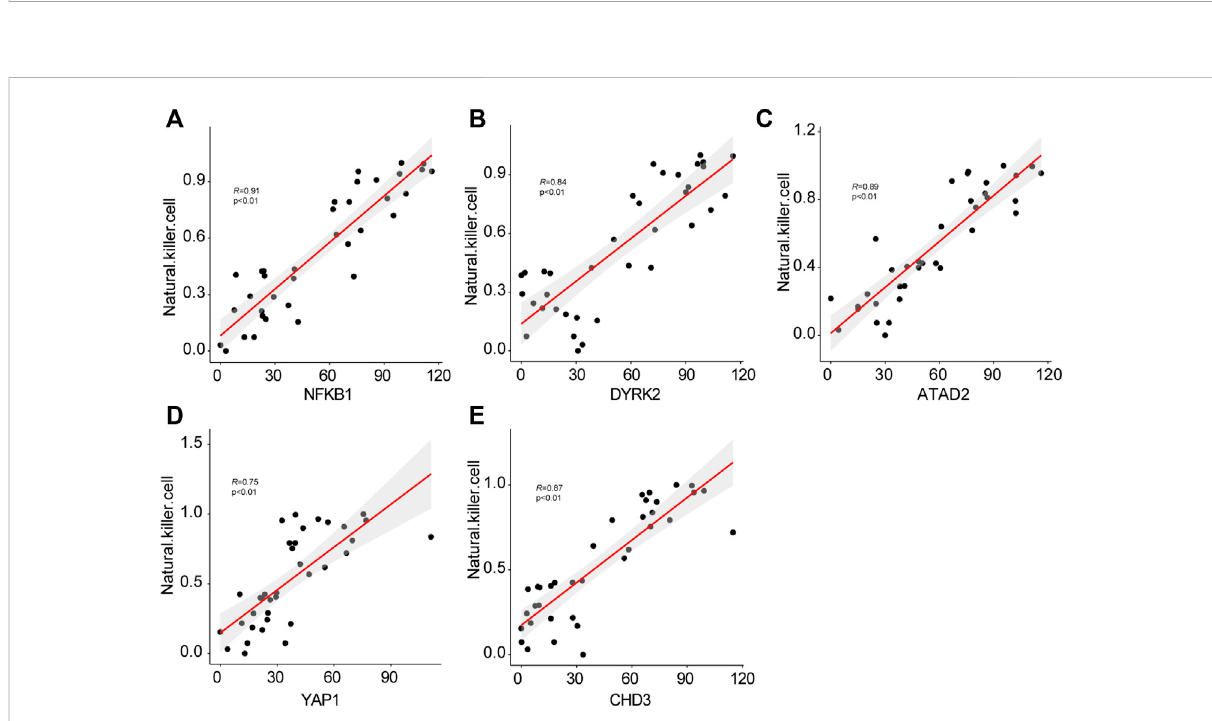
FIGURE 7 The correlations of hub genes NFKB1 (A) , DYRK2 (B) , AYTAD2 (C) , YAP1 (D) , CHD3 (E) with in fi ltrating natural killer